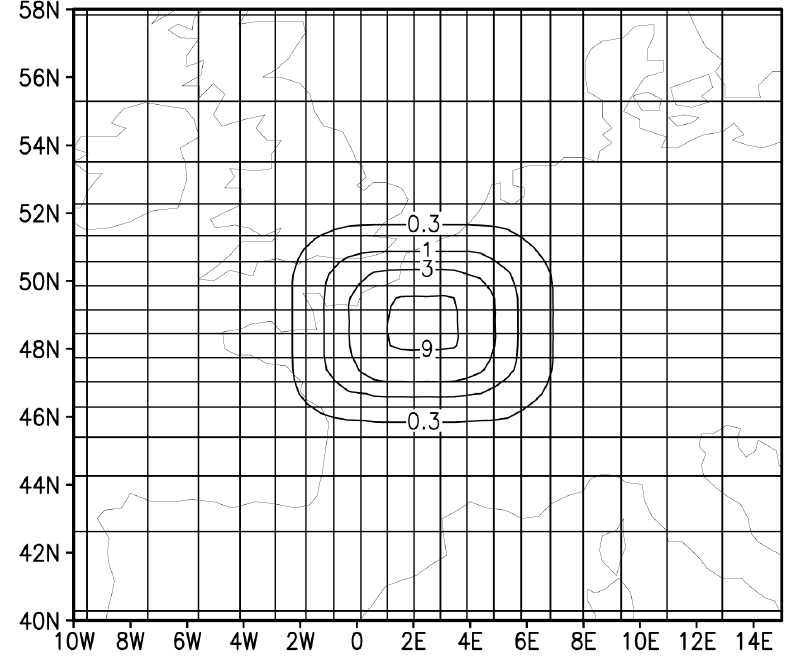
Fig. 9. Grid used in SIRTA simulations with LMDZ. The rectangles show the mesh zoomed on SIRTA. The contours correspond to relaxation time constants for nudging.